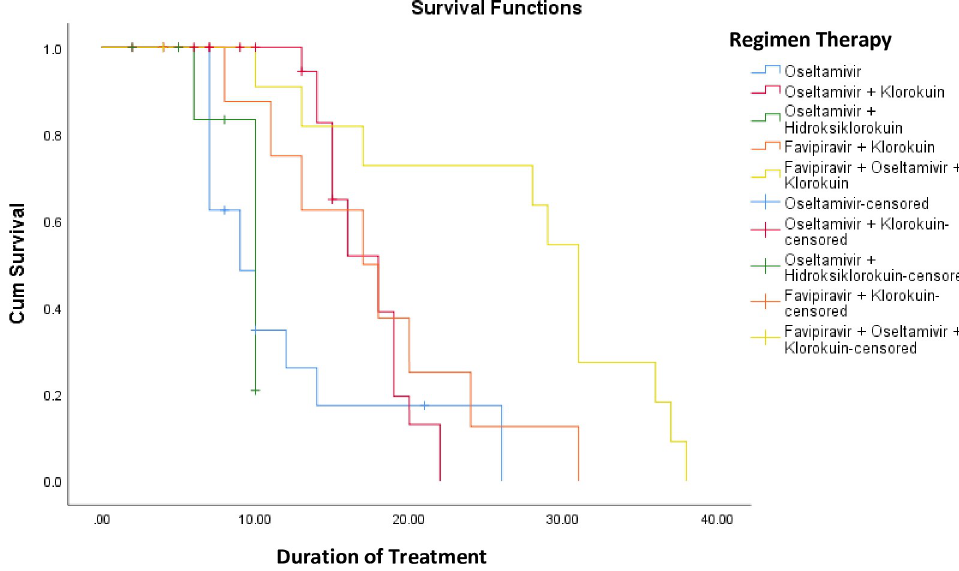
Fig 2. Survival analysis with Kaplan Meier